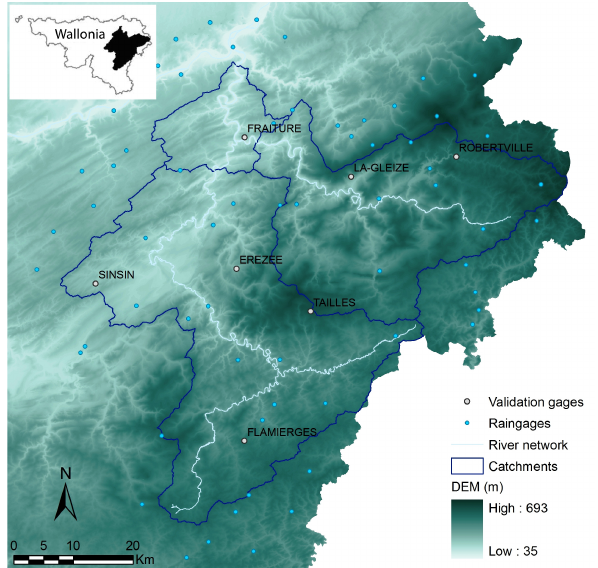
Fig. 3. Location of raingages and Digital Elevation Model of the Ourthe and Ambleve catchments, Walloon,